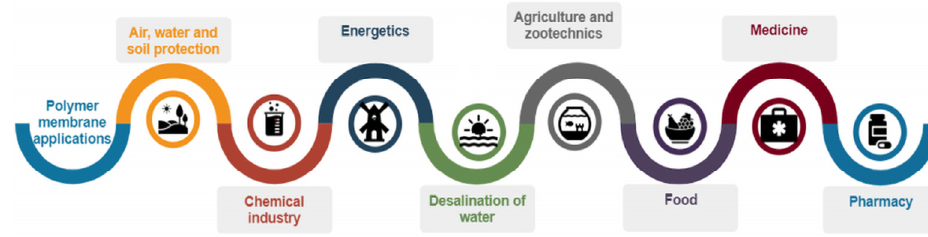
Figure 3. A schematic representation of polymer membrane applications.